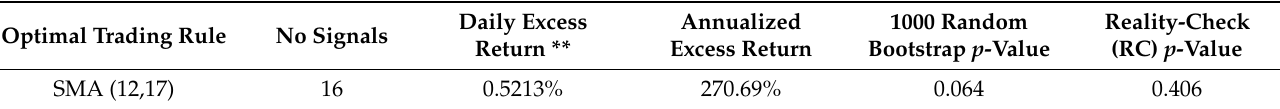
Table 4. Excess returns of the best performing trading rule on the Brent market during the COVID-19 pandemic (January 2020–March 2021) net of transaction costs *.